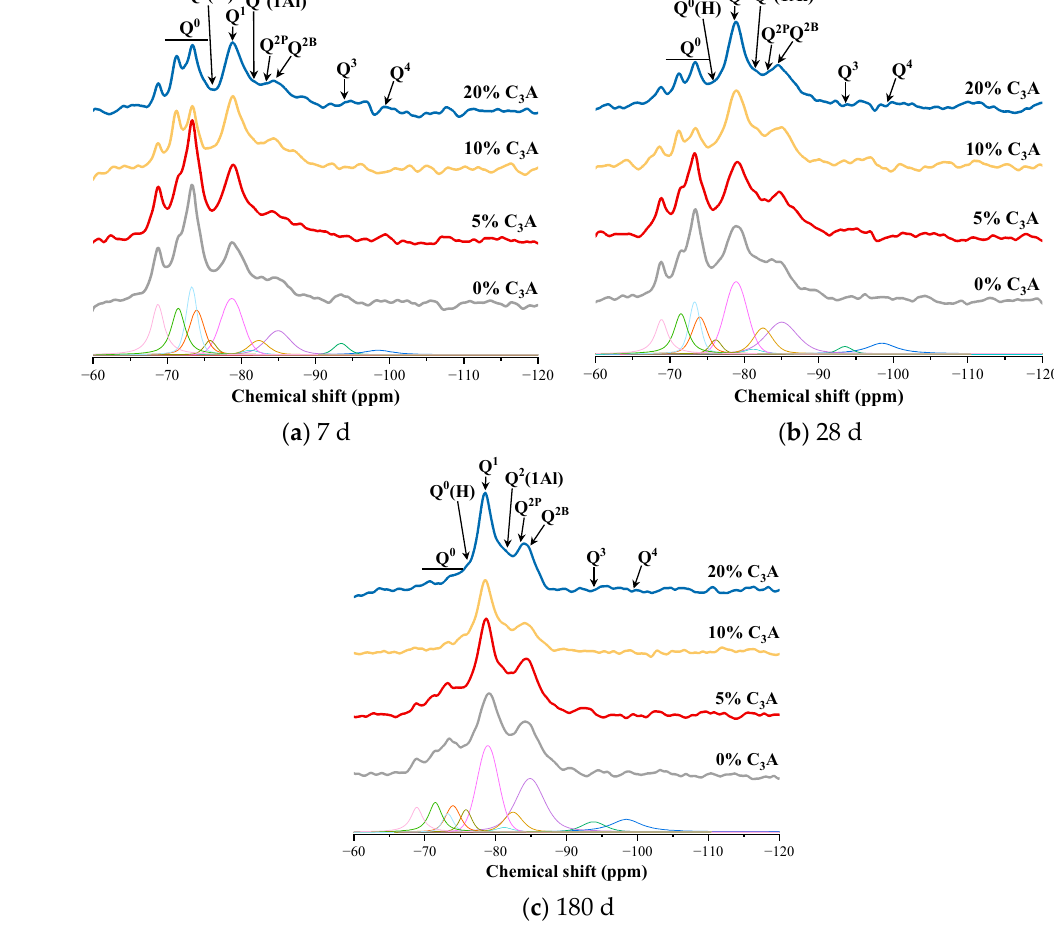
Figure 2. 29 Si NMR spectra of C 3 S-C 3 A paste under sulfate attack. Table 3. Deconvolution Results of 29 Si NMR Spectra.